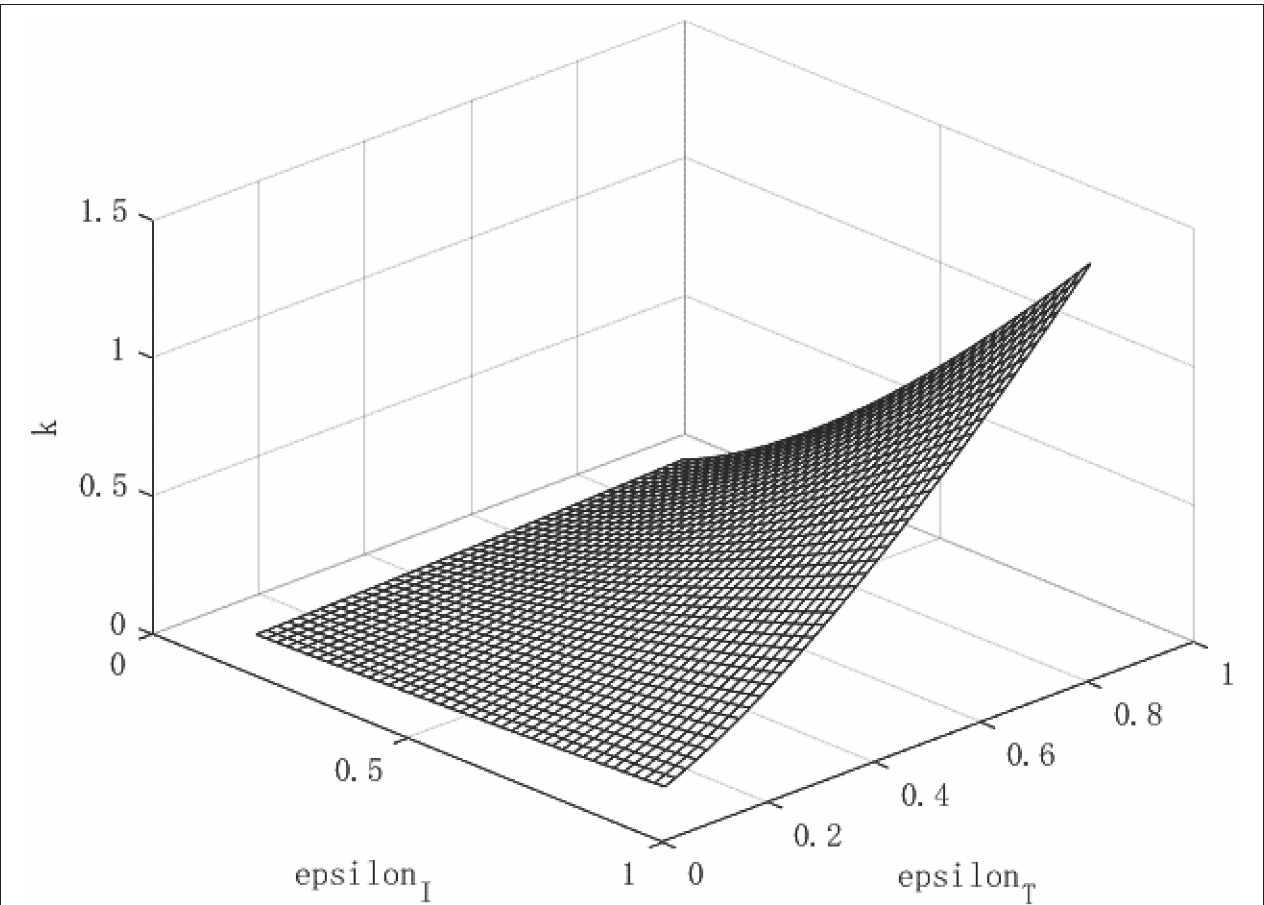
FIGURE 2 | Growth path of capital per capita under